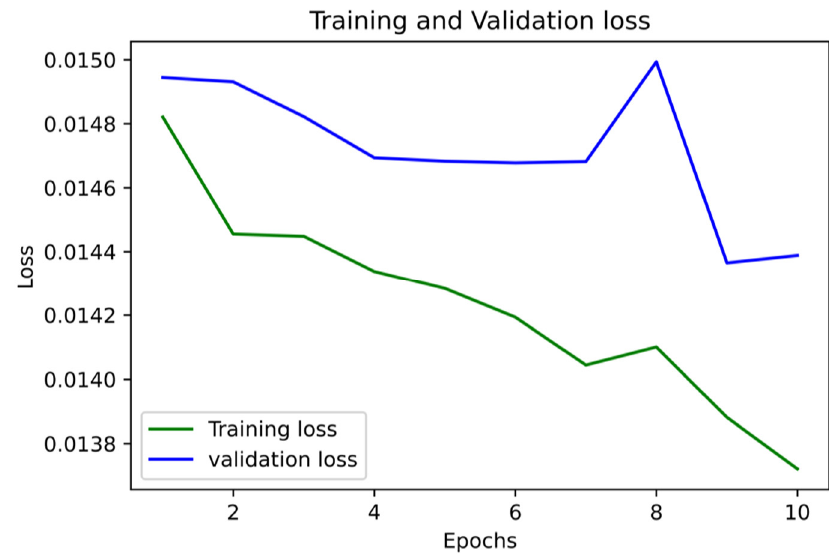
Medicina 2022 , 58 , x FOR PEER REVIEW Figure 6. LoS Plot for Mortality Prediction. Figure 6. LoS Plot for Mortality Prediction.